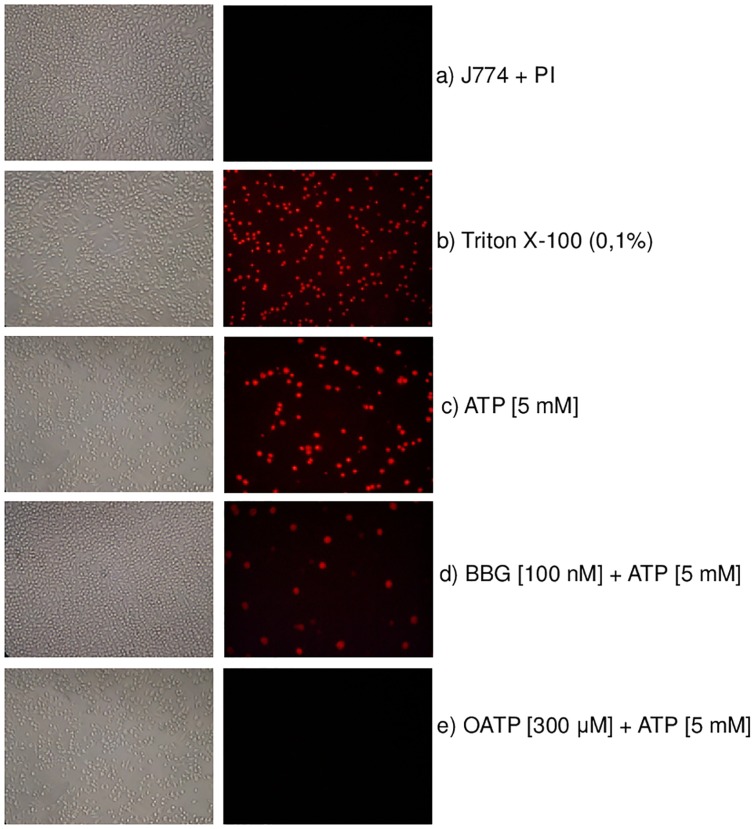
Evaluation of the inhibitory activity of BBG on P2X7 using fluorescence microscopy.J774.G8 cells were treated as follows: (a) Control (J774 plus PI [50 nM]), (b) permeabilization control (Triton-X 100 [0.1%]), (c) control cells plus ATP [5 mM], (d) cells treated with BBG [100 nM] plus ATP [5 mM] and (e) cells treated with OATP [300 μM] plus ATP [5 mM]. The profiles are representative of three to seven independent experiments that were performed in triplicate. The images were captured using a Nikon digital camera system with a total magnification of 43.8X.